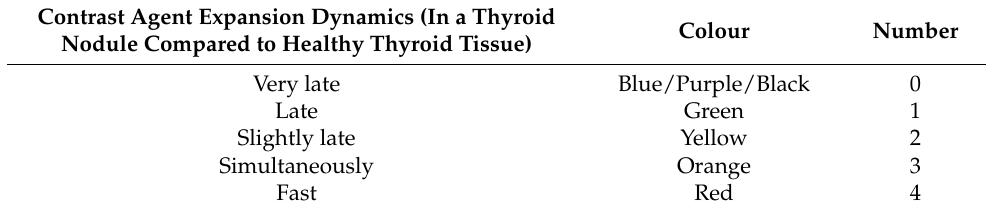
Table 1. Colour-coded contrast enhanced ultrasound (CEUS) microbubble expansion